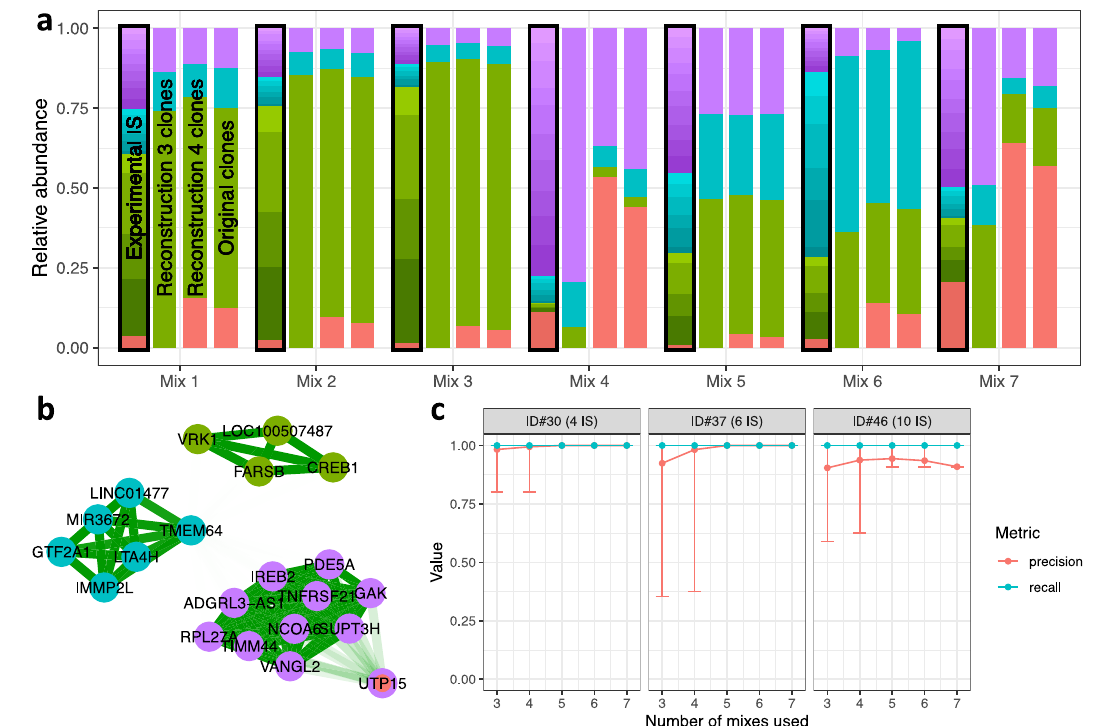
Fig. 5 Analysis of in vitro mixes of the validation assay. a For each of the seven analyzed samples (mixes 1 to 7) four stacked bar plots display from left to right: the relative proportion of measured IS after fi ltering (black contour, highlighting the available data in an experimental/clinical context, although the assignment to one of the four clones (i.e., the coloring) is generally unknown), the relative proportion of the different clones after applying the reconstruction routine, the relative proportion of the different clones after manual correction (see text), and the relative proportion of the four original clones. b Network map indicating the clustering of mutually similar IS. Shading of the edges indicates the mutual similarity R 2 . The inner color of each node represents the true assignment to one of the four clones, while the outer ring corresponds to the result of the reconstruction process. c Precision (true positives/(true positives + false positives)) and recall (true positives/(true positives + false negatives)) for the three clones ID#30, ID#37 and ID#46 containing 4, 6 and 10 IS, respectively. All available permutations for the different number of mixes (ranging from 3 mixes to the maximum number of 7 mixes, fi ltering for IS with a relative abundance > 0.5% in any of the selected mixes) were used to evaluate the benchmark parameters for the individual clones. Whiskers indicate the minimum and maximum values